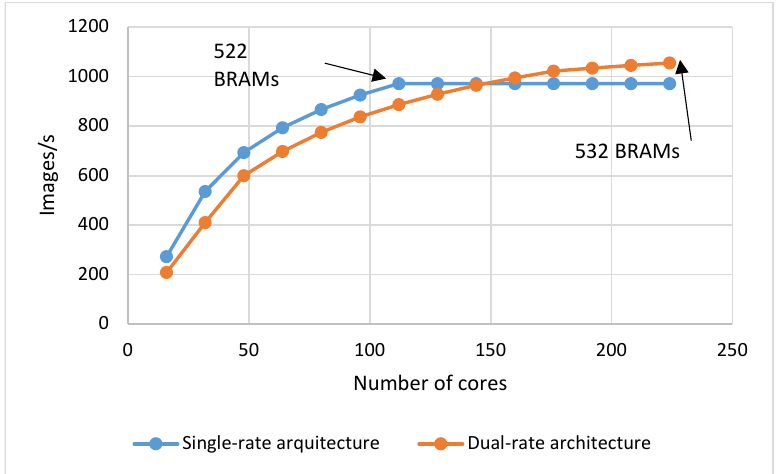
Figure 11. Performance breakthrough design point for fixed on-chip memory